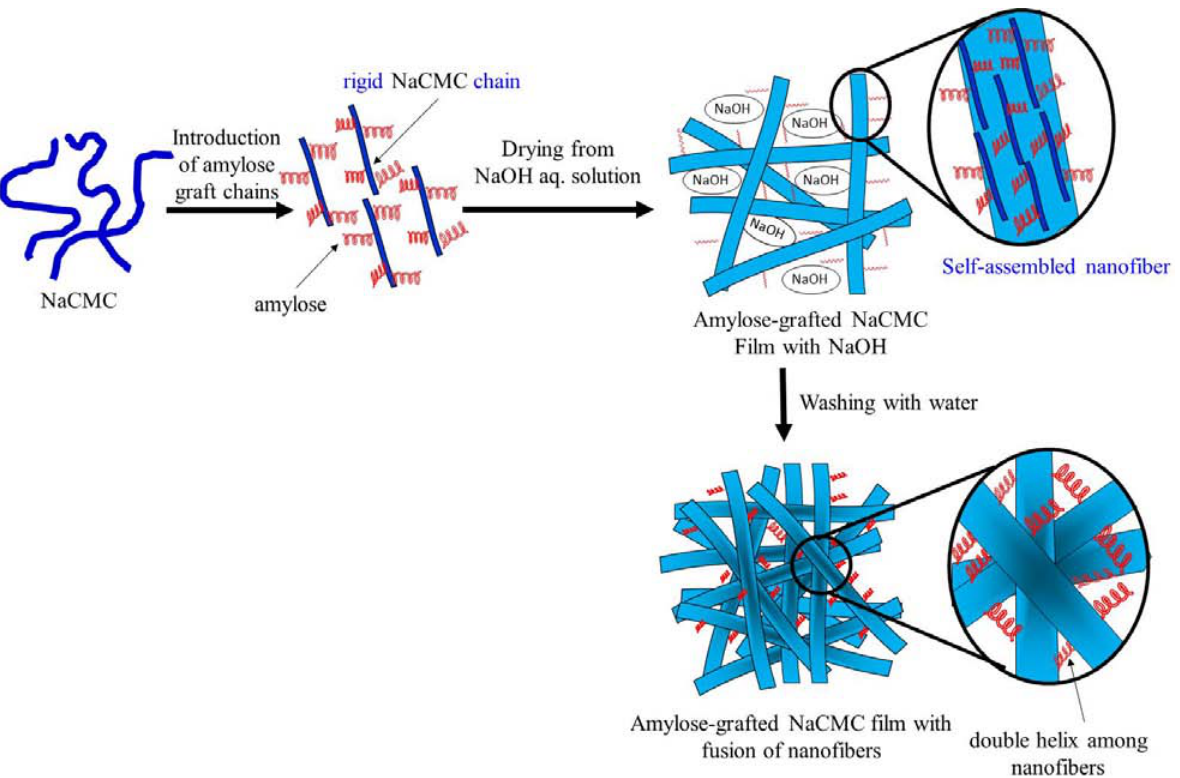
Figure 4. Proposed self-assembling process of 3 under alkaline conditions leading to nanofiber film.